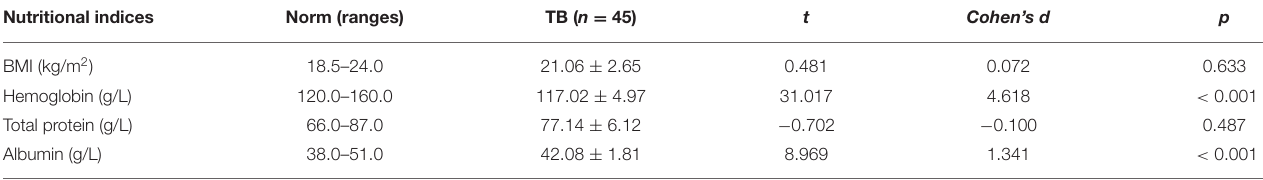
TABLE 5 | Nutritional indices (mean ±